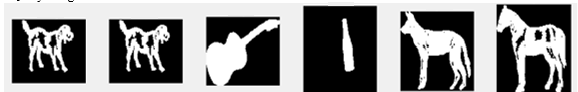
Figure 4. Image1 retievals using Fourier descriptors